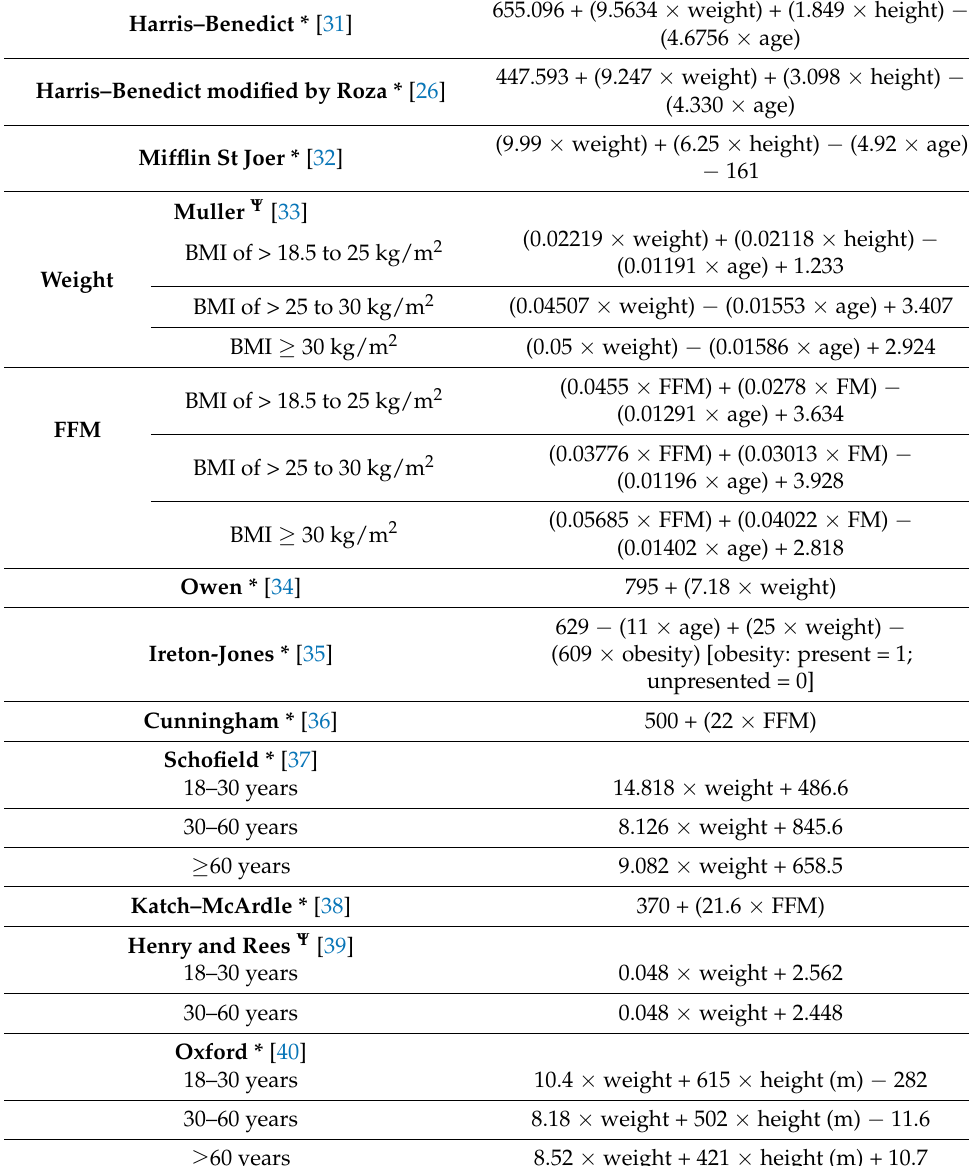
Table 1. Estimation formulas for